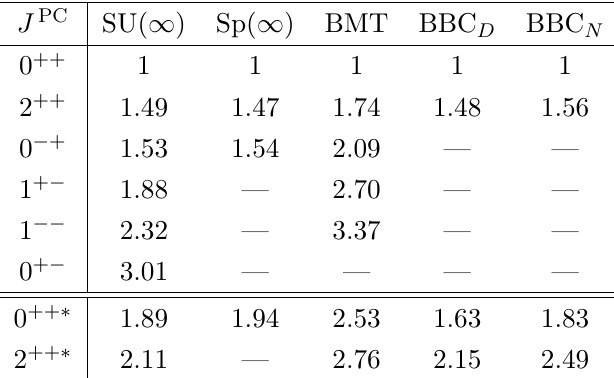
Table 3 . Spectra of the lightest glueballs in Witten’s (BMT [45]) and hard wall models (BBC [47]) compared to the state of the art lattice extrapolations of m ∞ for SU( N ) [28] and Sp( N ) [27]. The masses are normalized to the mass of the 0 ++ state. Models BBC N and BBC D used different boundary conditions (Neumann or Dirichlet) in the calculation of the